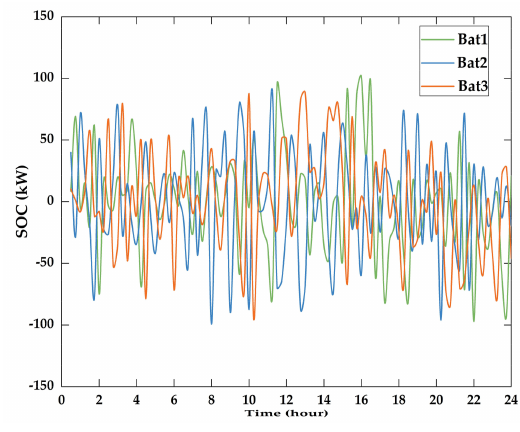
Figure 21. Battery power.